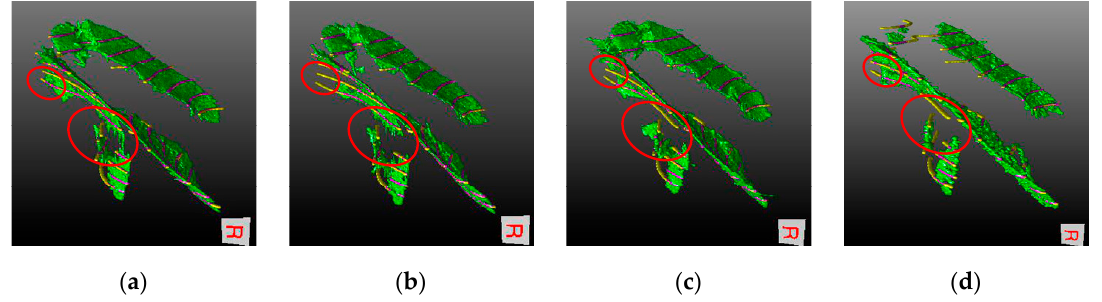
Figure 8. 3D fissure segmentation results from: ( a ) the proposed method, ( b ) the ODoS filter, ( c ) the DoS filter, and ( d ) the fissureness filter. Here, the cubes at the lower right corner indicate the view direction of the visualization in a standard anatomical coordinate system.